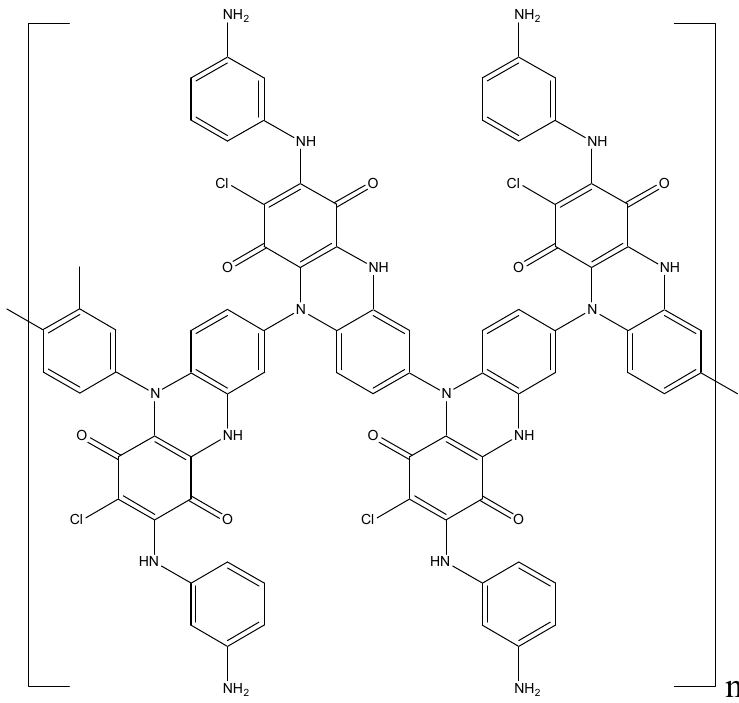
Figure 8. Intermediate polymer structure with hydrophenazine rings.